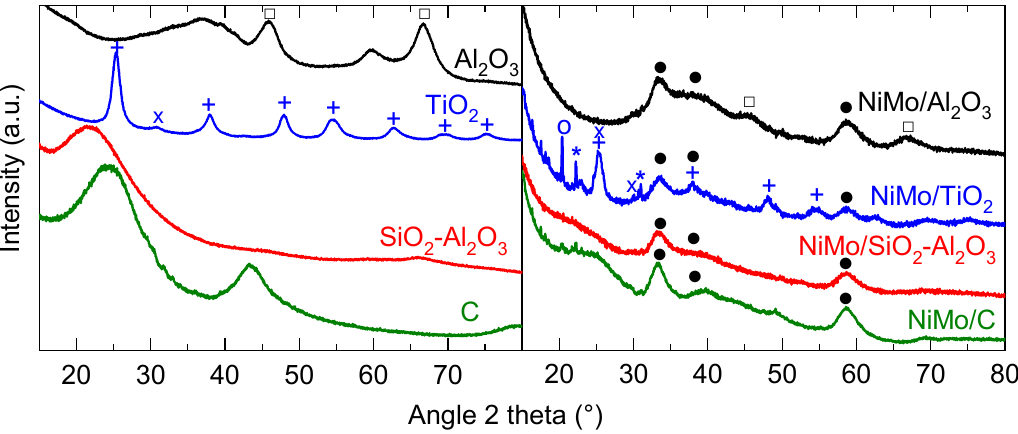
Figure 1. X-ray diffraction (XRD) patterns of supports and sulfide NiMo catalysts. Characteristic peaks of TiO 2 : (+) anatase, PDF 00-021-1272; (o) orthorhombic TiO 2 , PDF 01-082-1123; and (x) possibly brookite, PDF 00-029-1360. Characteristic peaks of Mo oxidic species (*): MoO 3 .H 2 O, PDF 00-026-1449 or Mo 9 O 26 , PDF 03-065-1292. Characteristics low intensity and broad peaks of gamma Al 2 O 3 ( □ ) and nanocrystallites of MoS 2 (•).